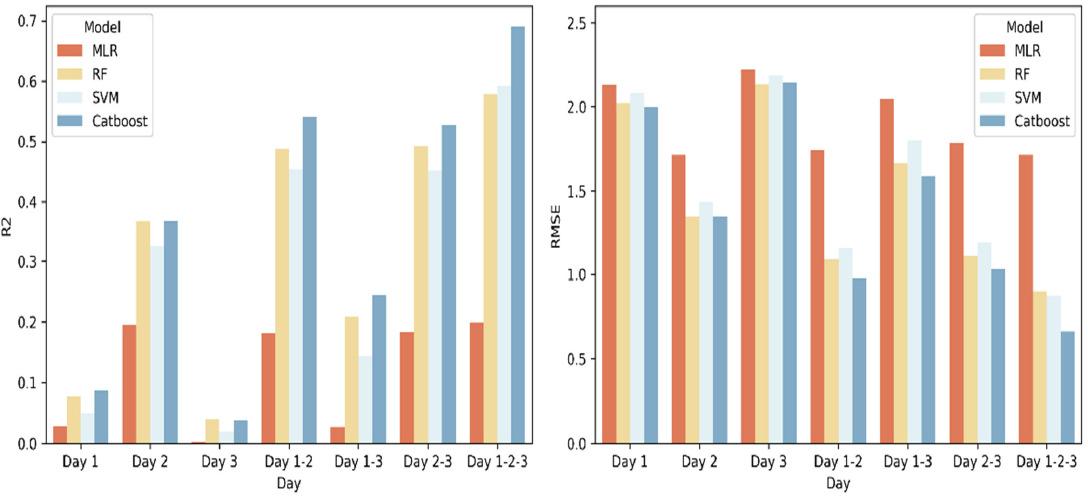
Figure 5. R 2 and RMSE of the four algorithms (MLR, Multiple Linear Model; RF, Random Forest; SVM, Support Vector Machine; CatBoost) when trained with VV and VH polarization backscatter information derived from S1 corresponding to three different dates. It also shows their combined use.